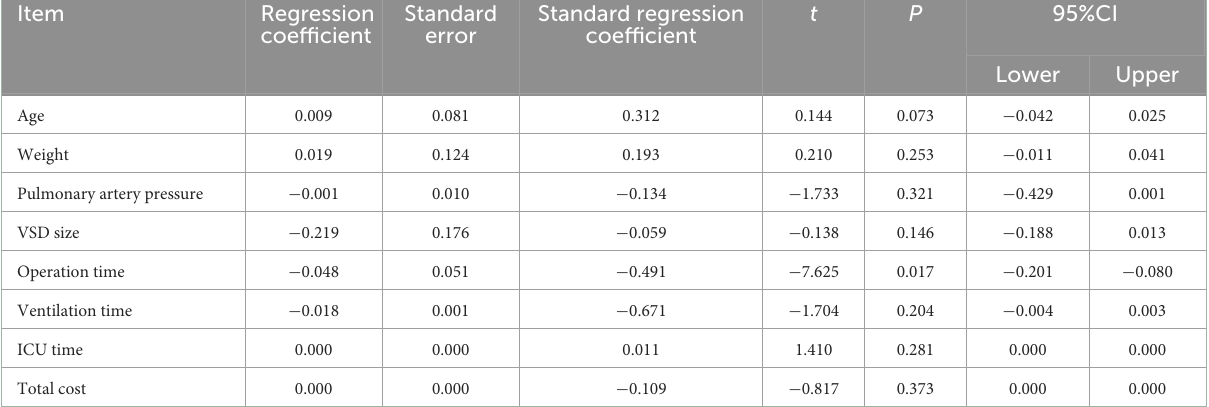
TABLE 5 Regression analysis of 6h serum lactate clearance rate in the matched transthoracic device closure group (D group).